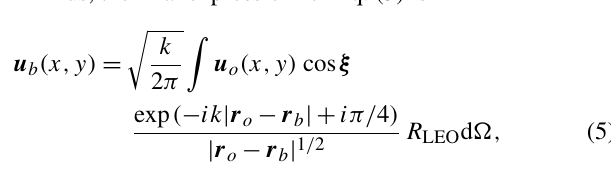
Figure 2. Illustration of the wave field generated on the GNSS transmitter (primary field) and the ionospheric mechanisms trig- gered by the secondary field due to the vibration of ions, followed by the overall expansion of the wave field until the observation plane (last phase